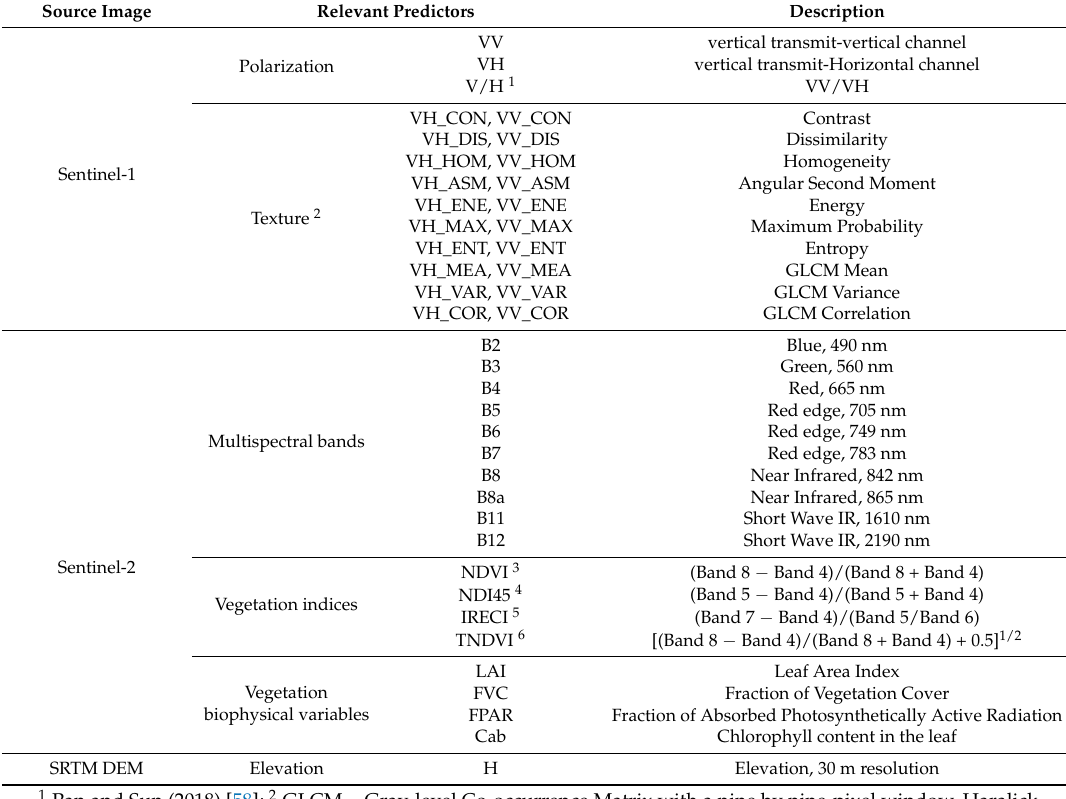
Table 3. Sentinel-based imagery data predictors of above-ground